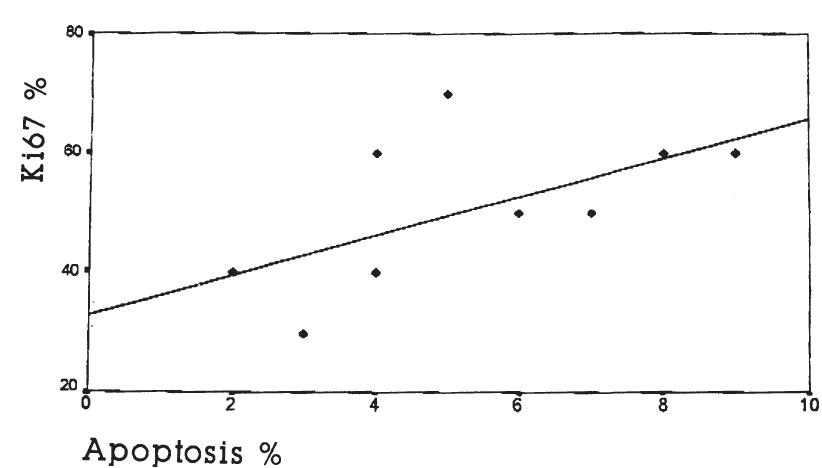
Fig. 7. Correlation between apoptotic cells % and Ki67 positive cells % in tubulovillous adenomas gained from the carcinoma-bearing bowel ( ρ = 0 . 59, p = 0 . 07, N =